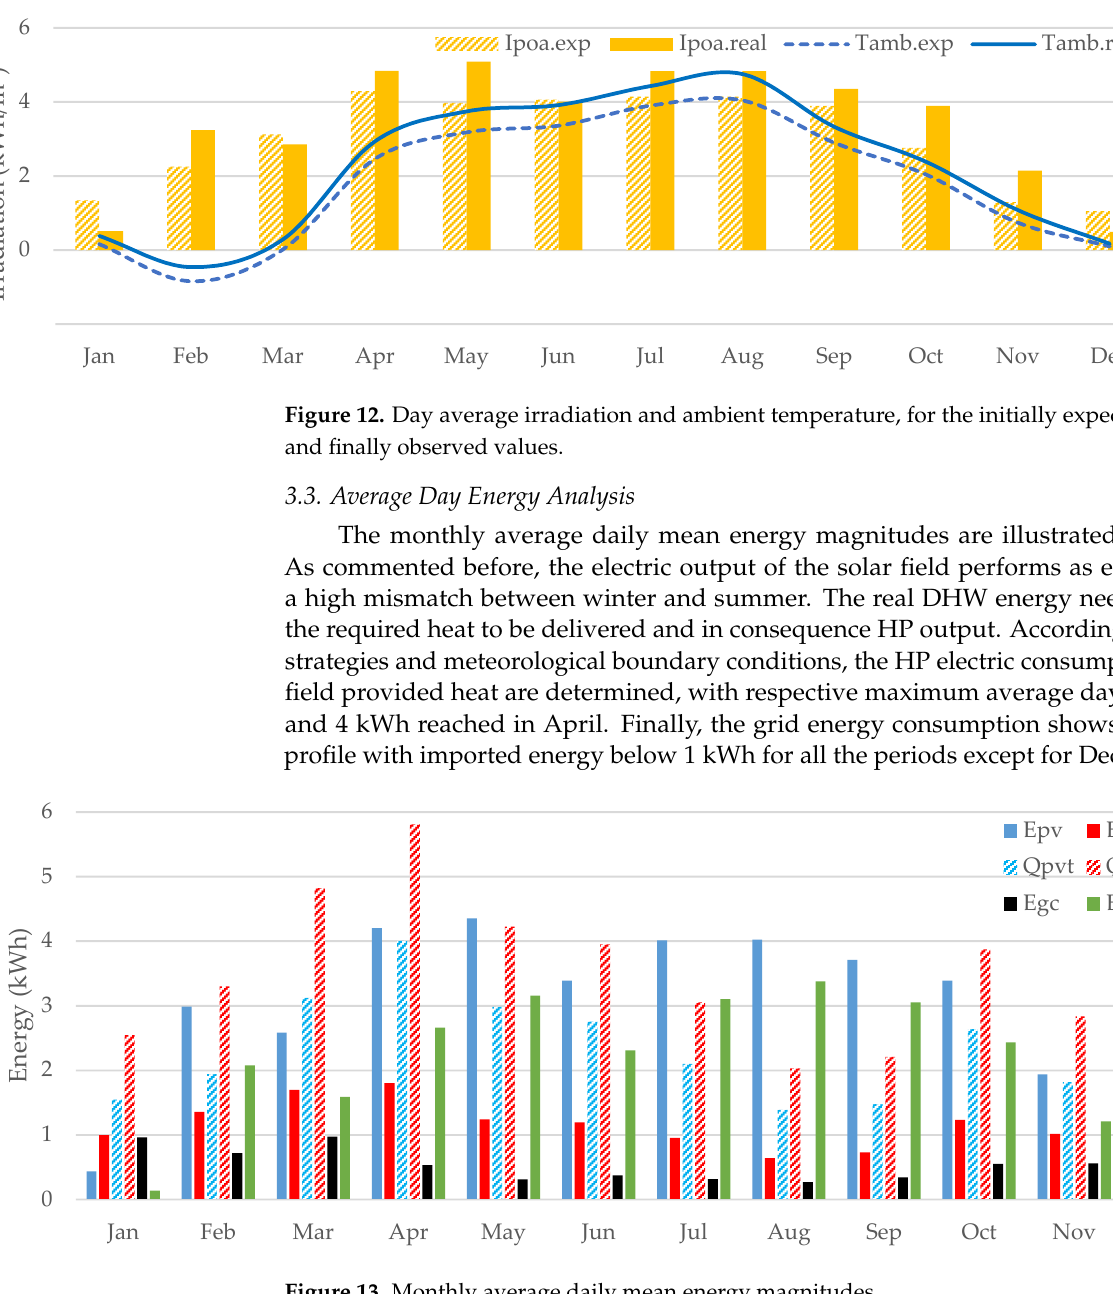
Figure 14. Monthly average daily mean DHW consumption and the energy source.